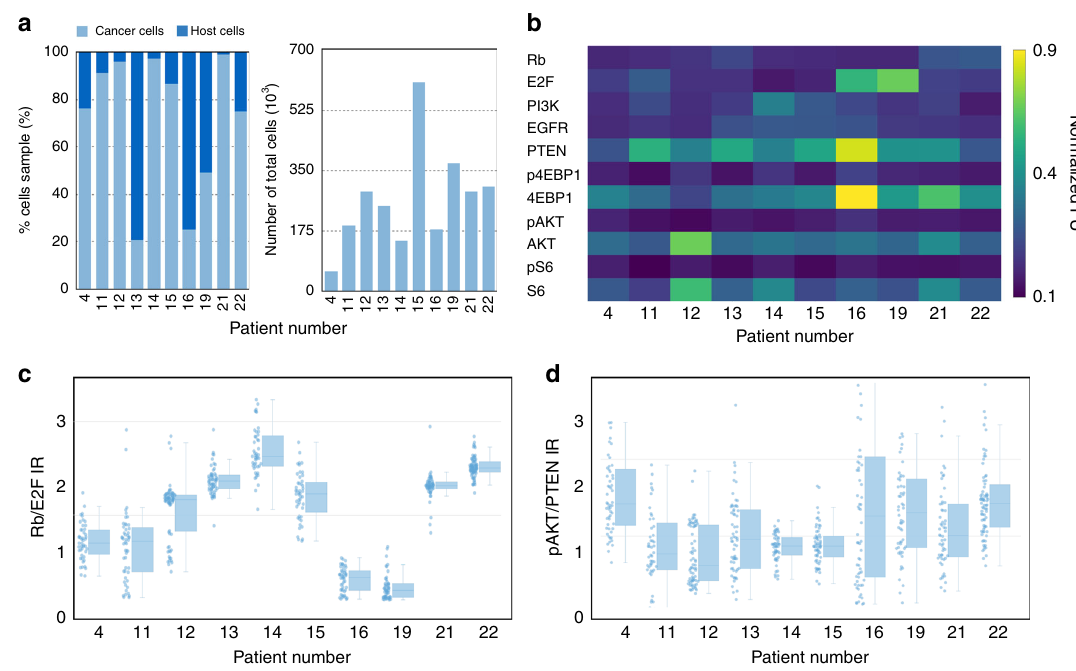
Fig. 6 Analysis of clinical samples. a Calibration experiments to identify the composition of samples. Host cell analysis of clinical samples demonstrates that tumor cells made up a large fraction of the cells within FNAs. However, there was considerable heterogeneity amongst patients. b Heterogeneity of key drug targets measured in pretreatment clinical samples. c Analysis of the ratio of Rb/E2F shows the heterogeneity within a given patient and also between patients. d Measurement of pAKT/PTEN ratios in the same patients displays increased cell-to-cell variability but less overall